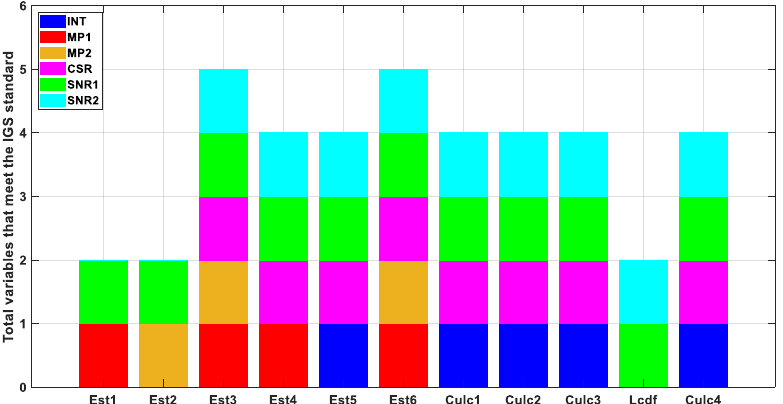
Figure 9. Variables that meet the standards established by the IGS. The values of: MP1 = 1, MP2 = 1, SNR1 = 1; SNR 2 = 1; CSR = 1; INT = 1, are assigned if the variables are accomplished.